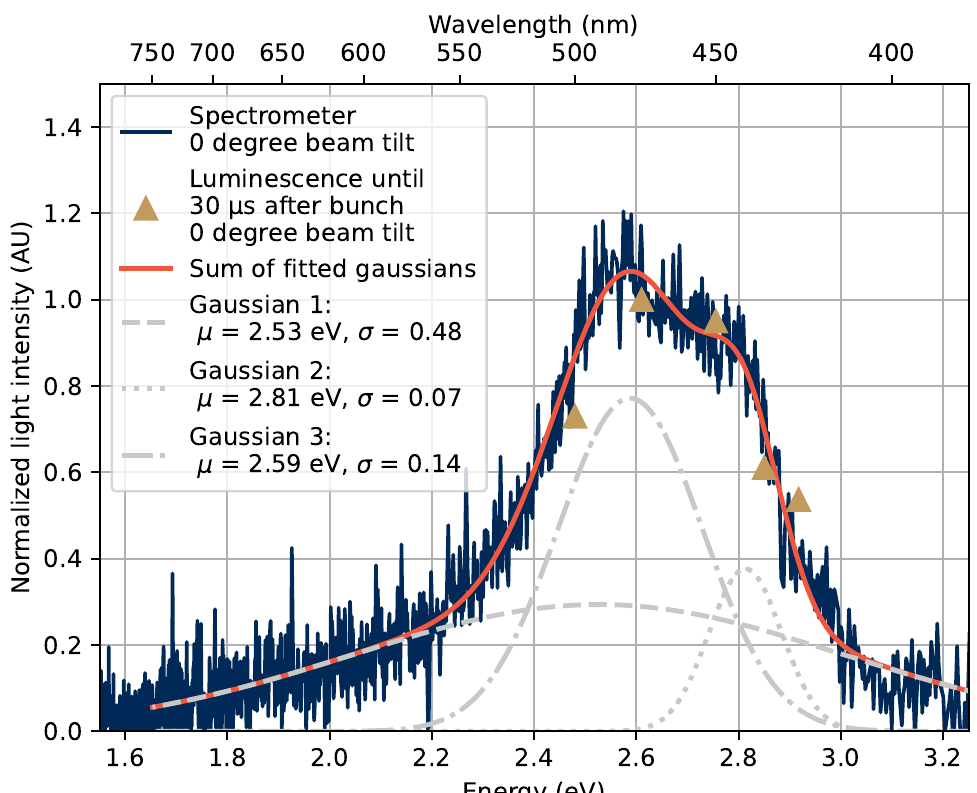
Figure 12. The observed peak in the optical emission spectrum between 400 nm and 600 nm. The structure is reproduced with an optical spectrometer as the blue line, and by summing the detected photons in the luminescence time region marked in Figure 11 by gold-dashed lines, resulting in the points marked by gold triangles in this figure. The spectrometer measurement was also fitted to a sum of three Gaussian components to recreate the peak